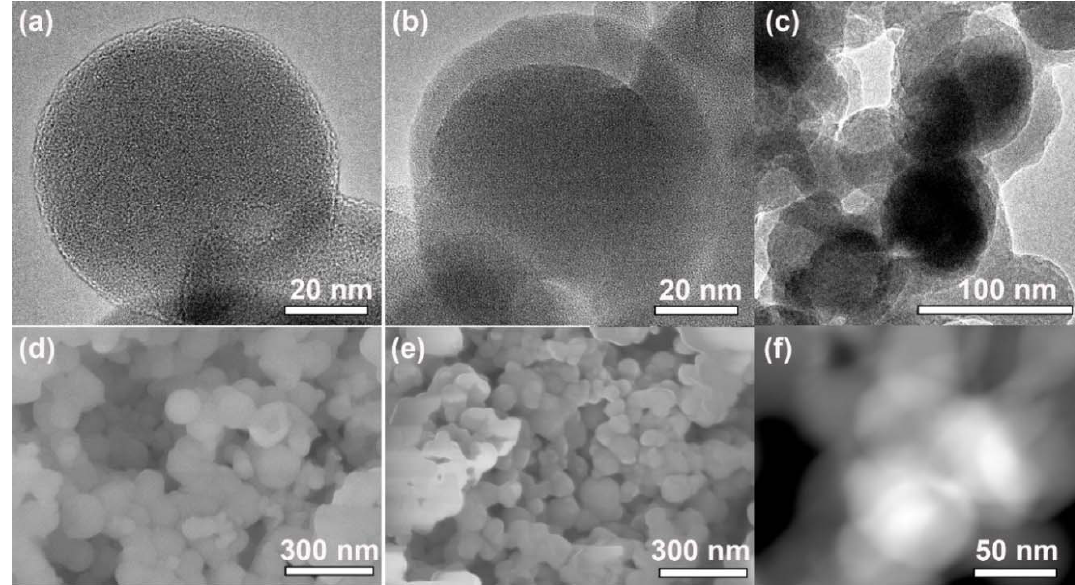
Figure 2. TEM images of ( a ) RPNPs and ( b ) RPNP@PEDOT; SEM images of ( d ) RPNPs and ( e ) RPNP@PEDOT; ( c ) wide- range TEM picture of RPNP@PEDOT and ( f ) the corresponding HAADF image of RPNP@PEDOT.